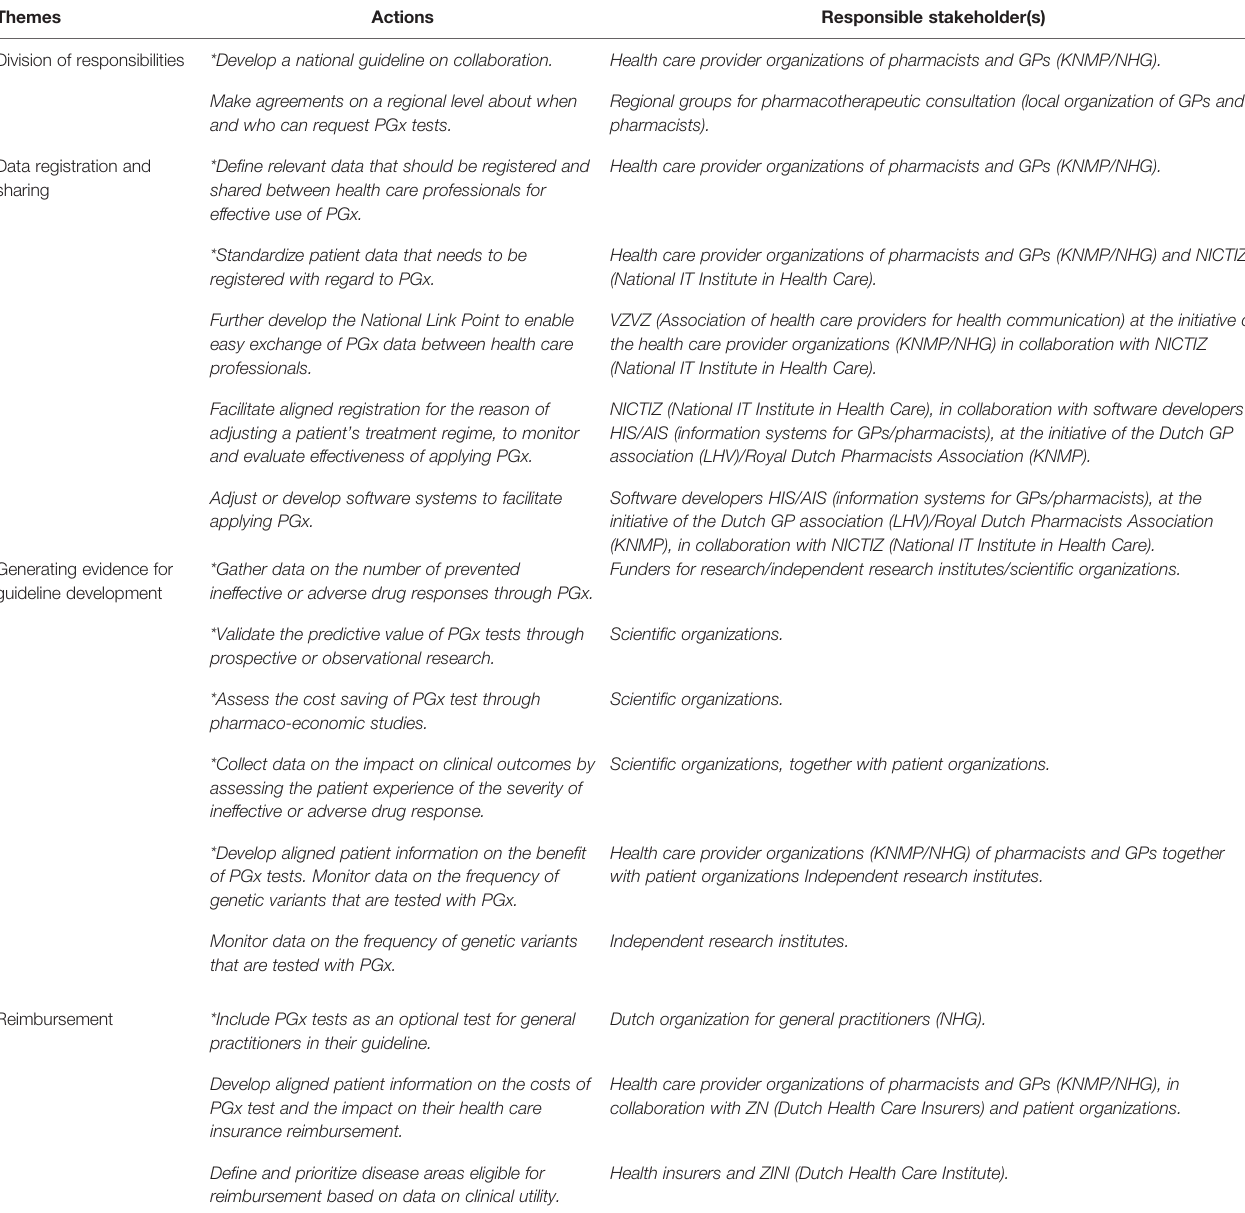
TABLE 1 | Actions, roles, and responsibilities as discussed in the expert